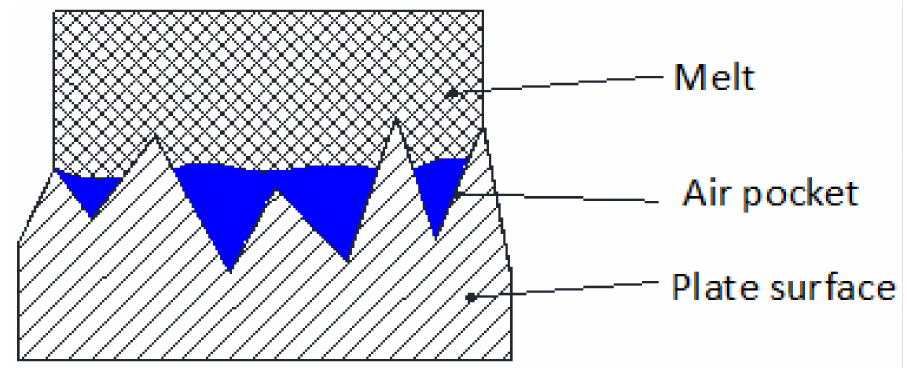
Figure A3. Vzduchov á bari é ra mezi formou a polymerem.